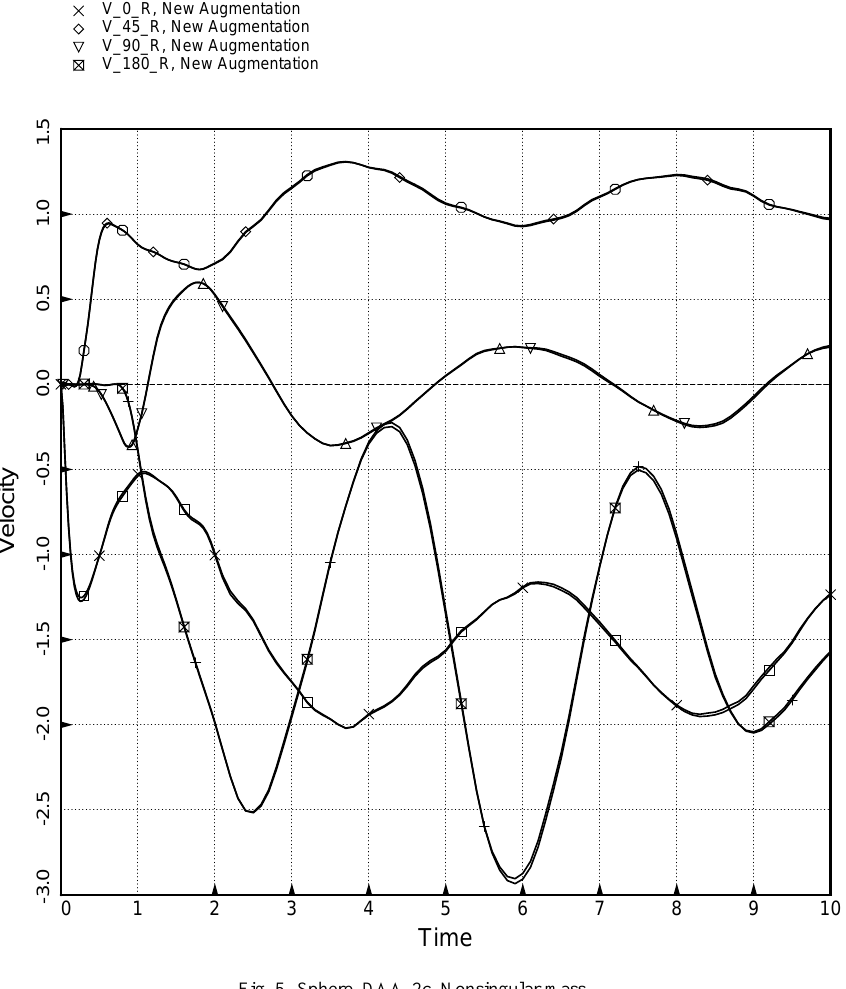
Fig. 5. Sphere, DAA 2c, Nonsingular